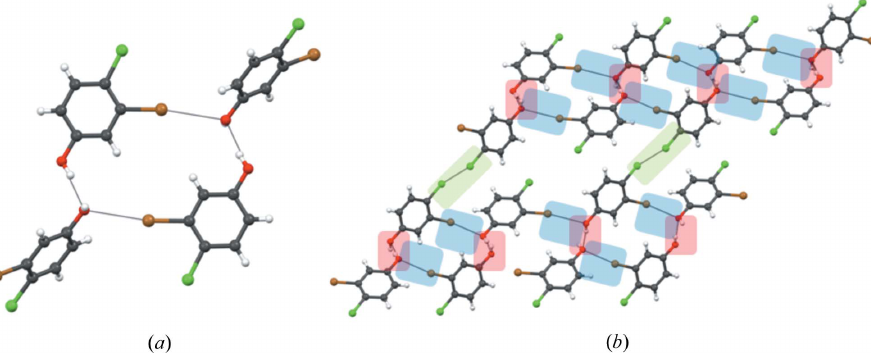
Figure 3 3-Bromo-4-chlorophenol ( 3 ): ( a ) Primary synthon comprising O—H (cid:2)(cid:2)(cid:2) O hydrogen bonds and short Br (cid:2)(cid:2)(cid:2) O interactions. ( b ) Primary synthons joined through Cl (cid:2)(cid:2)(cid:2) Cl type I contacts. Colour code: O— H (cid:2)(cid:2)(cid:2) O hydrogen bond (red), type II Br (cid:2)(cid:2)(cid:2) O (blue) and type I Cl (cid:2)(cid:2)(cid:2) Cl (light